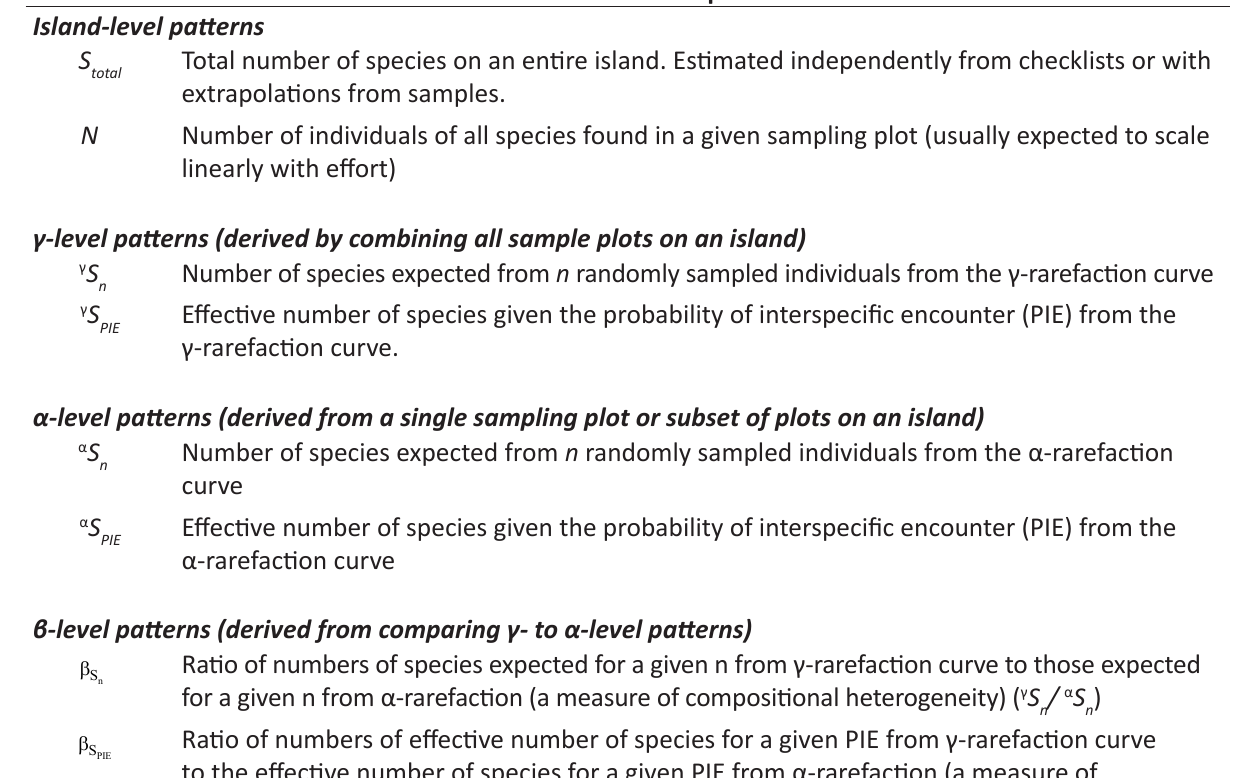
Table 1. Parameters used to disentangle island species–area relationship patterns